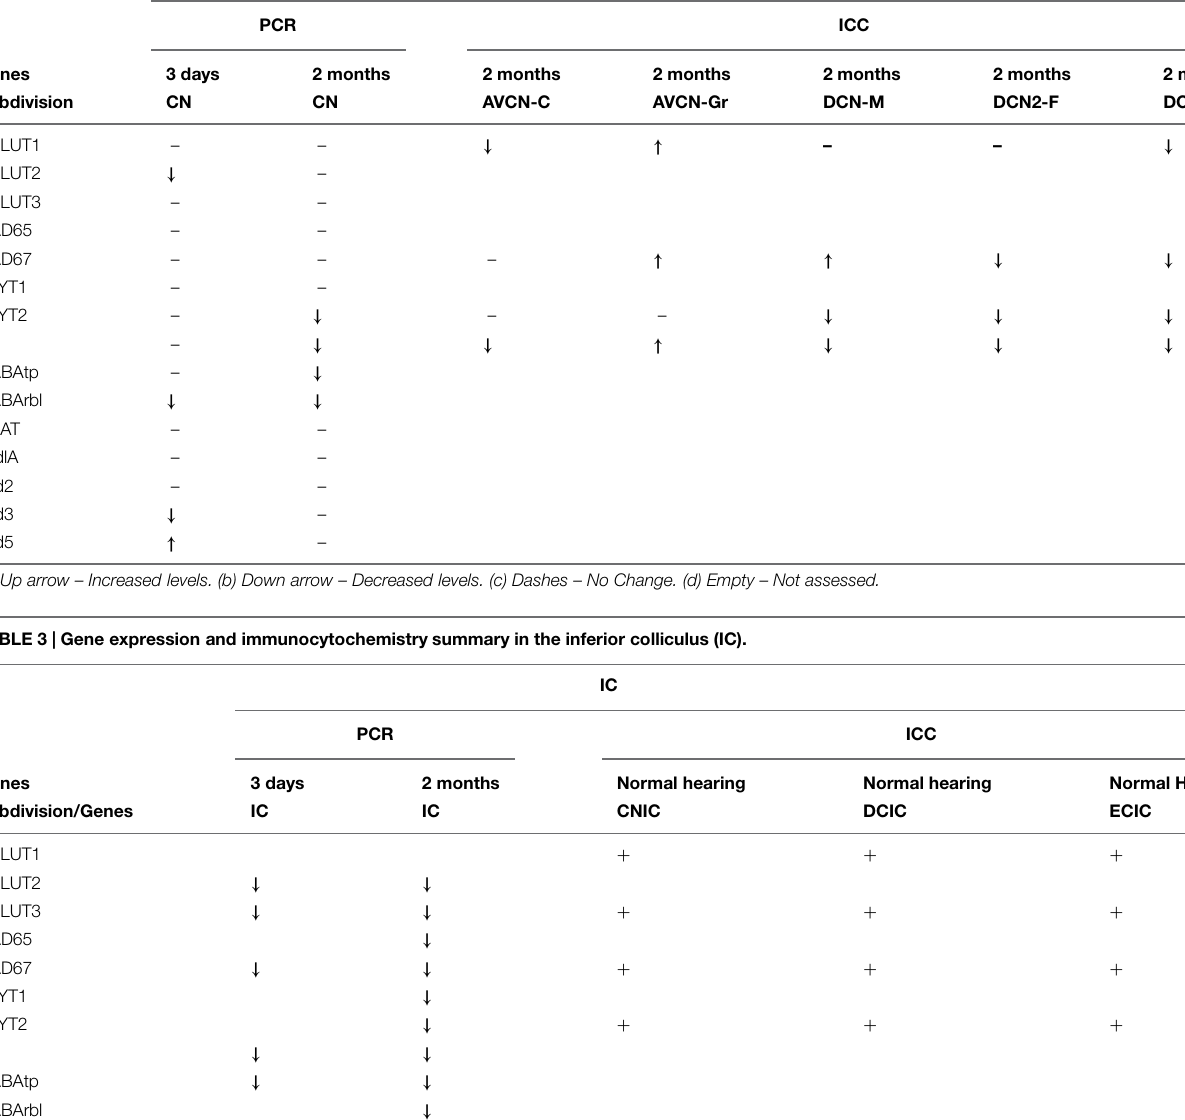
TABLE 2 | Gene expression and immunocytochemistry comparison in the cochlear nucleus (CN).